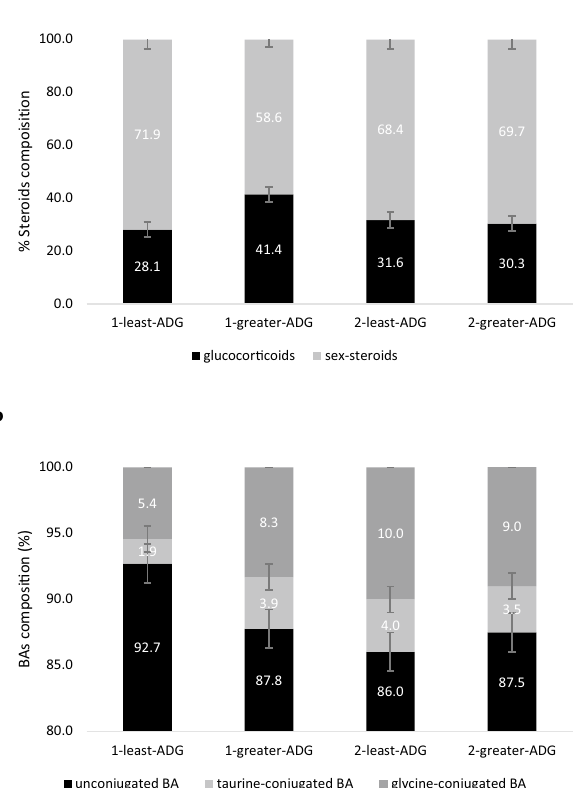
Figure 5. Urine steroids ( a ) and bile acids composition ( b ) (%) for ADG-classification in stage-1 and stage- 2. Results are shown as means ± SE of all steers averaging the results of the 6 sampling times (n = 145). Urine glucocorticoids and sex-steroids (testosterone + progesterone) tended to be significant ( P = 0.10) between ADG-classification in stage-1 but were not significant in stage-2. Urine bile acids composition of unconjugated, taurine-conjugated and glycine-conjugated were different ( P < 0.05) in stage-1 but did not differ in